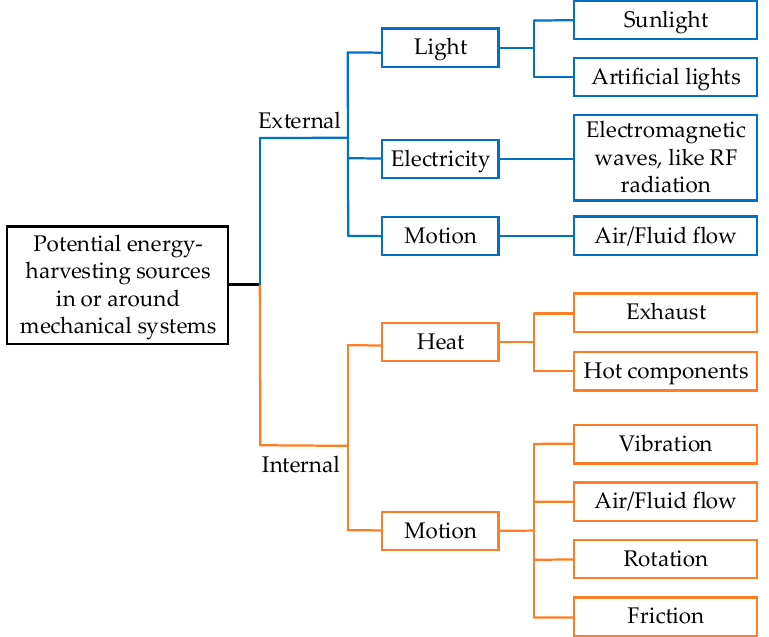
Figure 2. Potential energy-harvesting sources in mechanical systems.